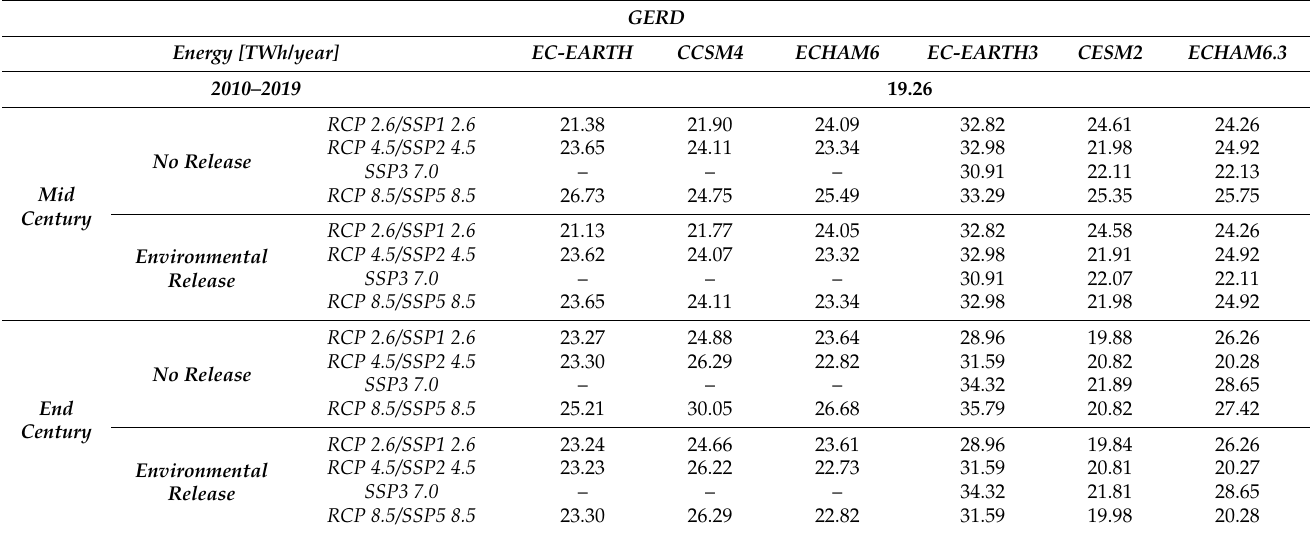
Table 7. GERD. Average projected yearly hydropower